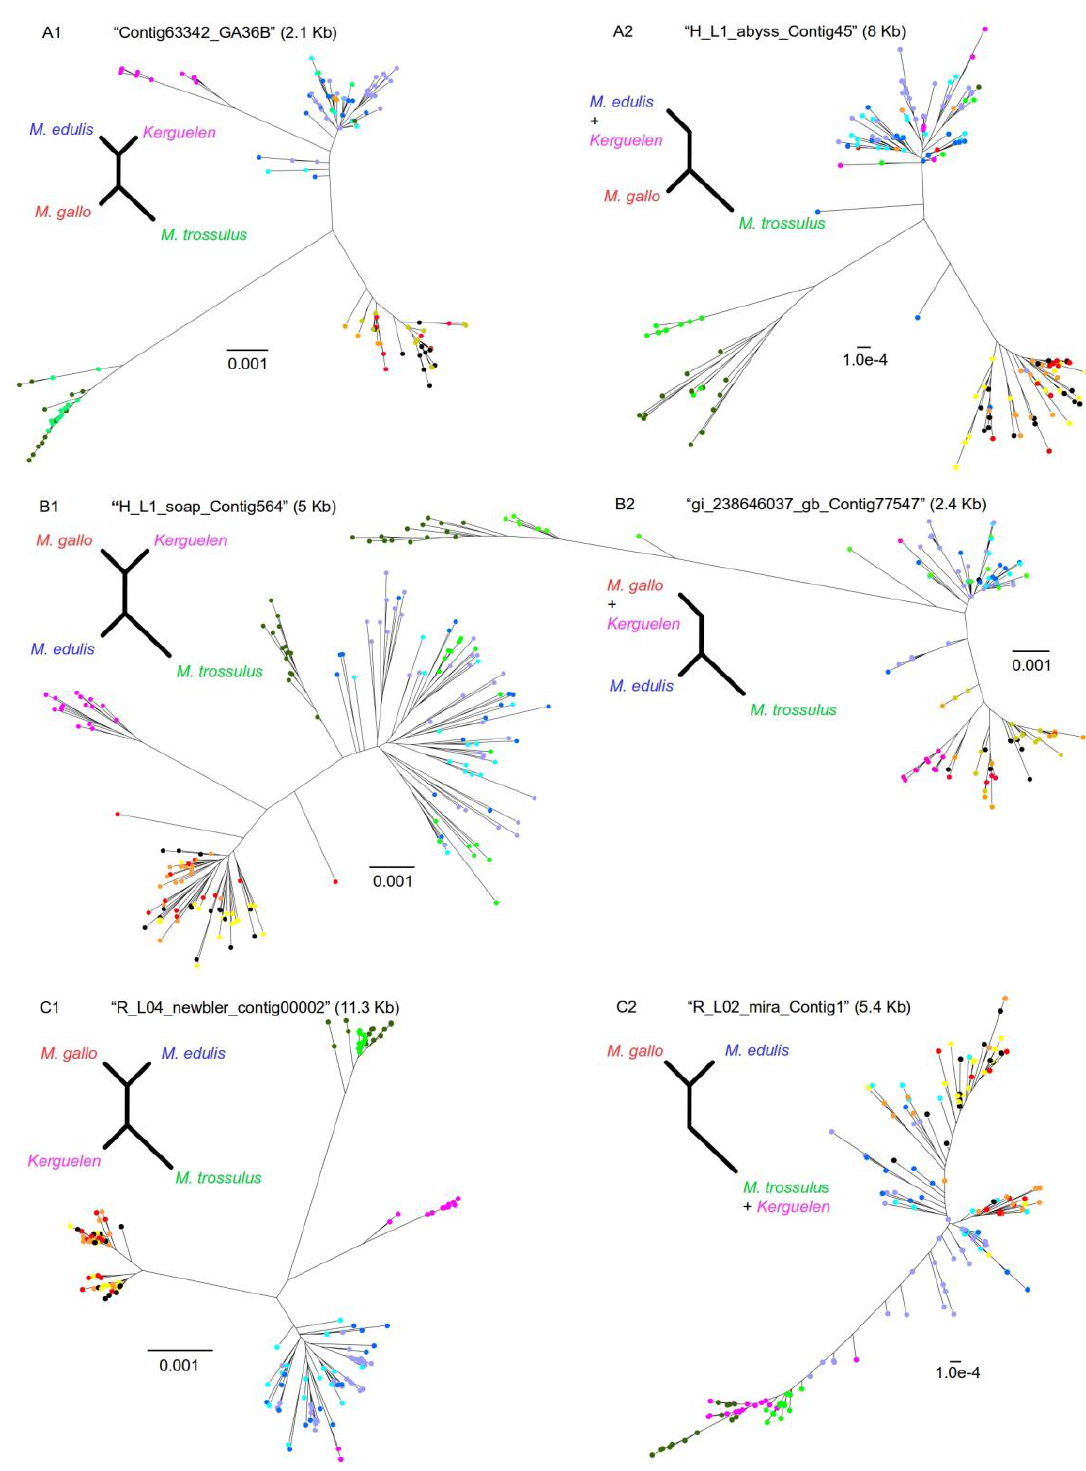
Figure 3. Summary of the different gene topologies obtained with Twisst for the GBS dataset. Three topologies have been weighed with Twisst for each of the 395 contigs (of which only 67 were topologically resolved), and classified in different categories depending whether the Kerguelen mussels branched as a sister- clade to a Northern species (“ancient divergence”), or were distributed within a Northern species (“introgression”). A. Kerguelen clustered with Mytilus trossulus : A1 “ancient Kerguelen divergence” and A2: “introgression”; B. Kerguelen clustered with Mytilus edulis : B1 “ancient Kerguelen divergence” and B2: “introgression”; C. Kerguelen clustered with Mytilus galloprovincialis : C1 “ancient Kerguelen divergence” and C2: “introgression”. For each category, a typical neighbour -joining tree computed on the longest